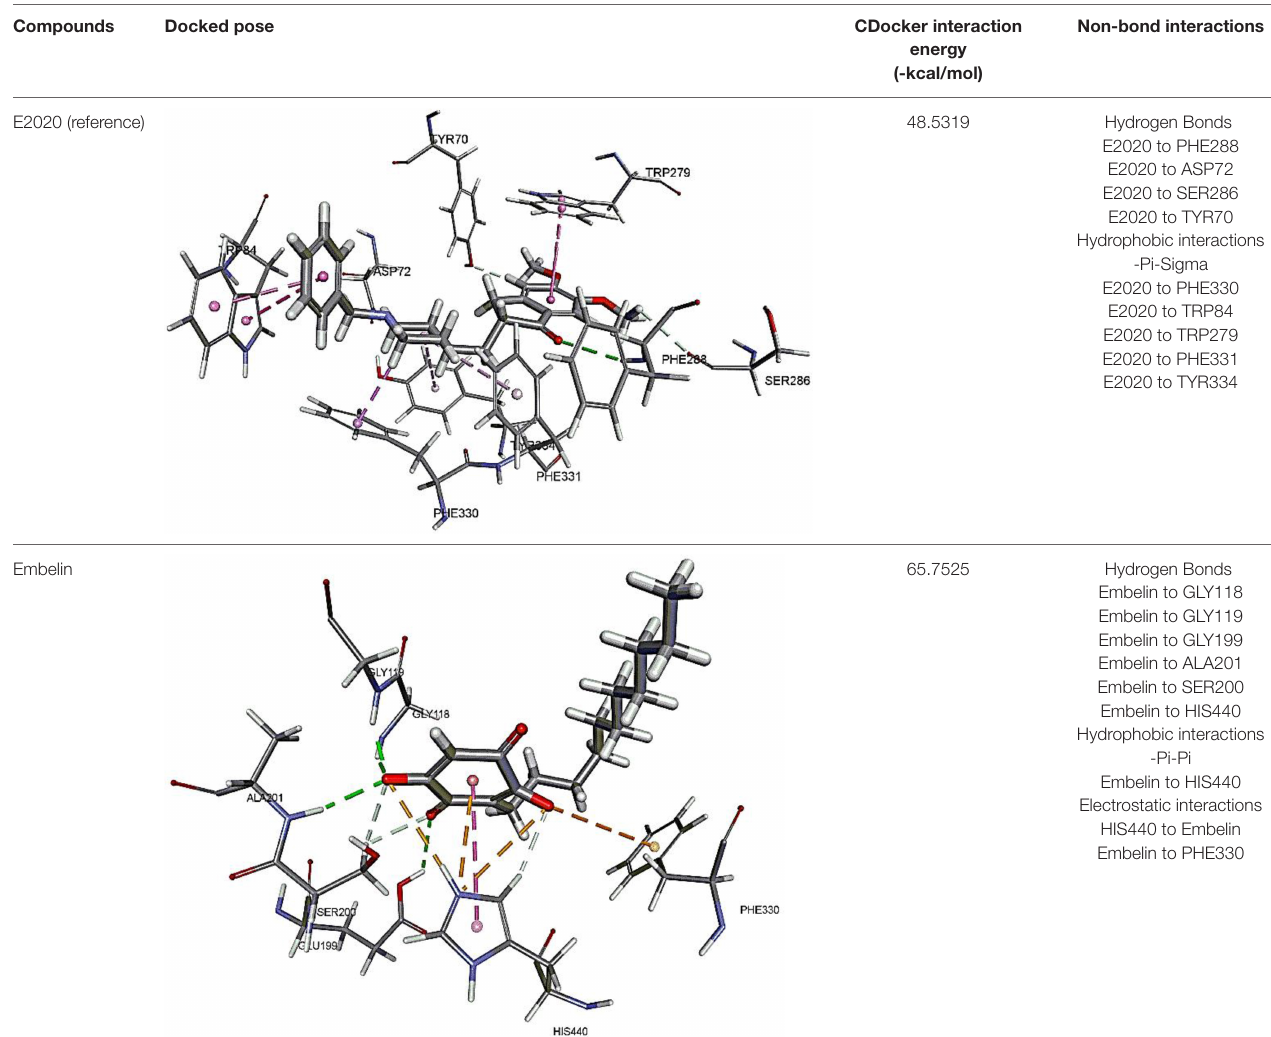
TABLE 2 | Binding modes of embelin docked to AChE active sites.